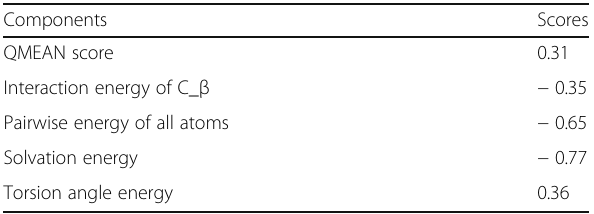
Table 1 Z-score for the individual components of QMEAN for the model